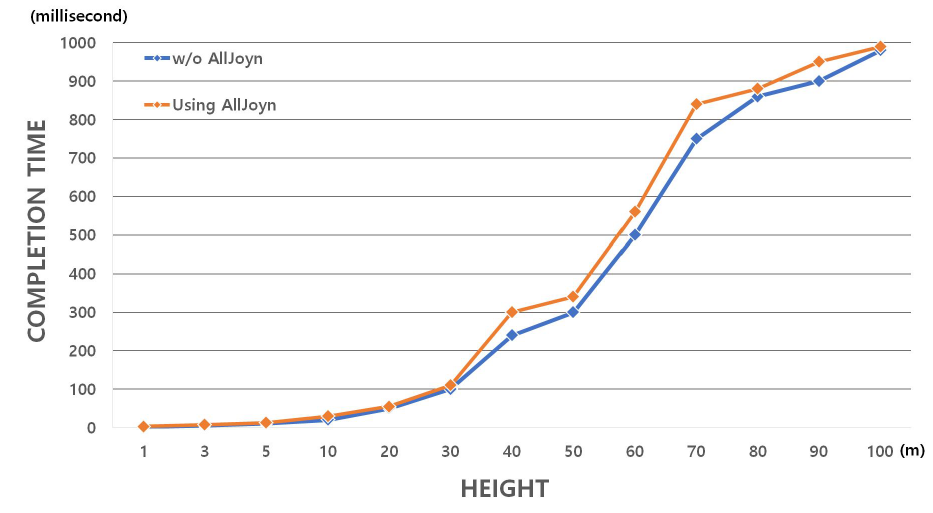
Figure 10. The communication and computation overhead according to flight